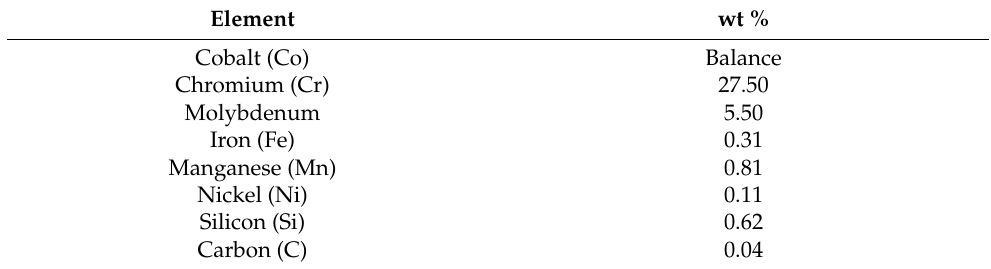
Table 1. Chemical composition of the CoCrMo